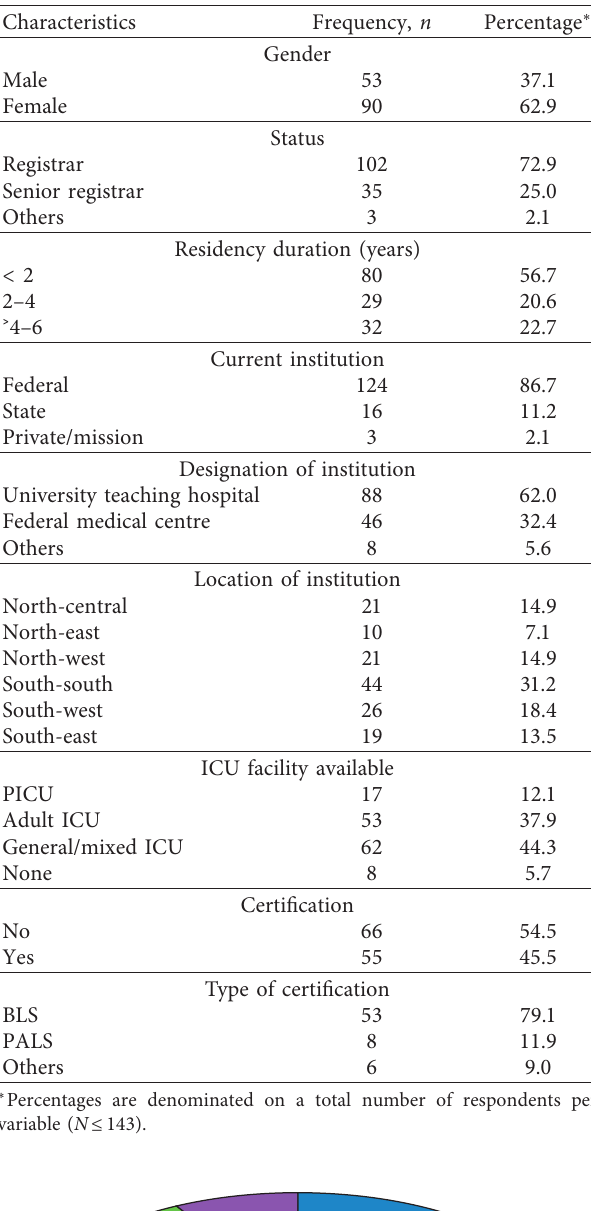
Table 1: Baseline characteristics of the study participants ( N � 143).